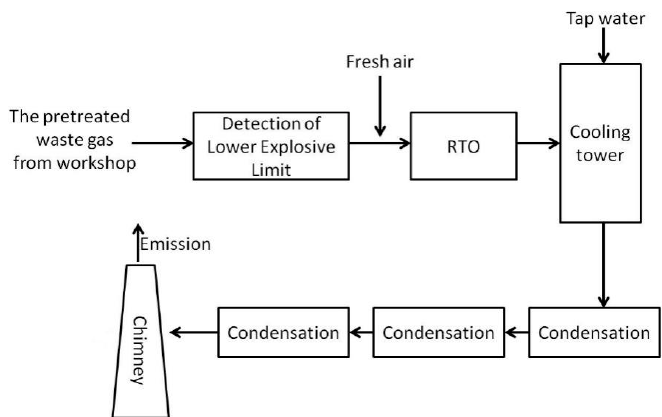
Figure 11. VOCs abatement process in the B and C factory, utilizing a regenerative thermal oxidizer (RTO) and condensation. Reprinted with permission from [4], 2016, CNKI.